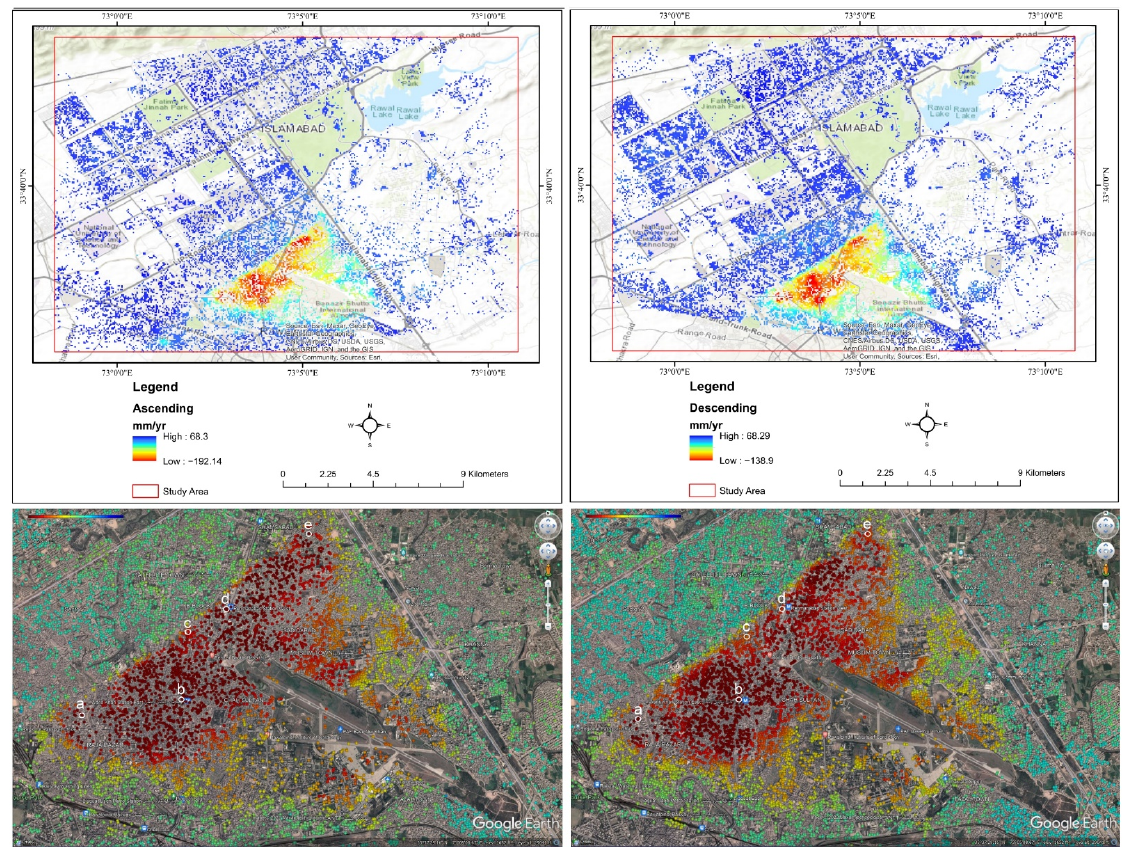
Figure 11. Land subsidence in the study area at different points (a, b, c, d, and e) from both ascending and descending tracks.